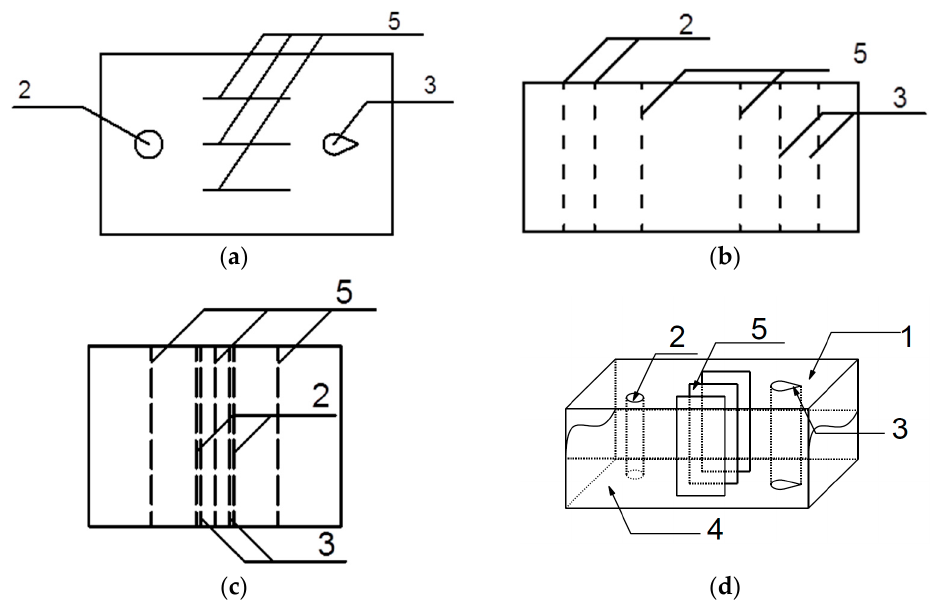
Figure 2. Design of KV-TLD: ( a ) plane; ( b ) front elevation; ( c ) left side elevation; ( d ) 3D. Note: 1–container; 2—cylindrical bluff body; 3—streamline body; 4—fluid (in the experiment of this paper, fluid means water); 5—rectangular partition.